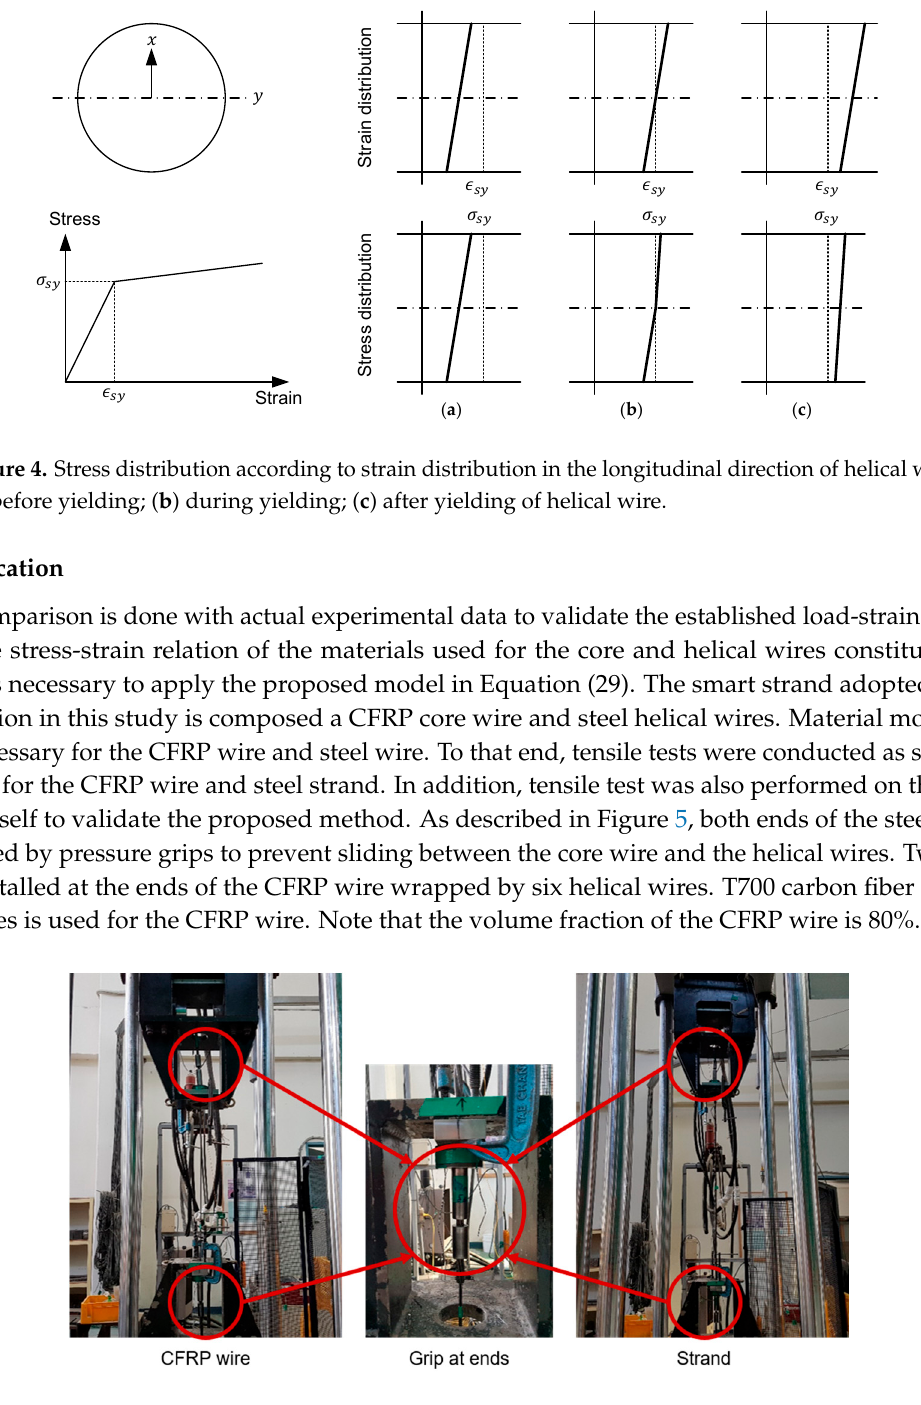
Figure 5. View of tensile test conducted on CFRP (Carbon Fiber-Reinforced Polymer) wire, steel strand, and smart strand.